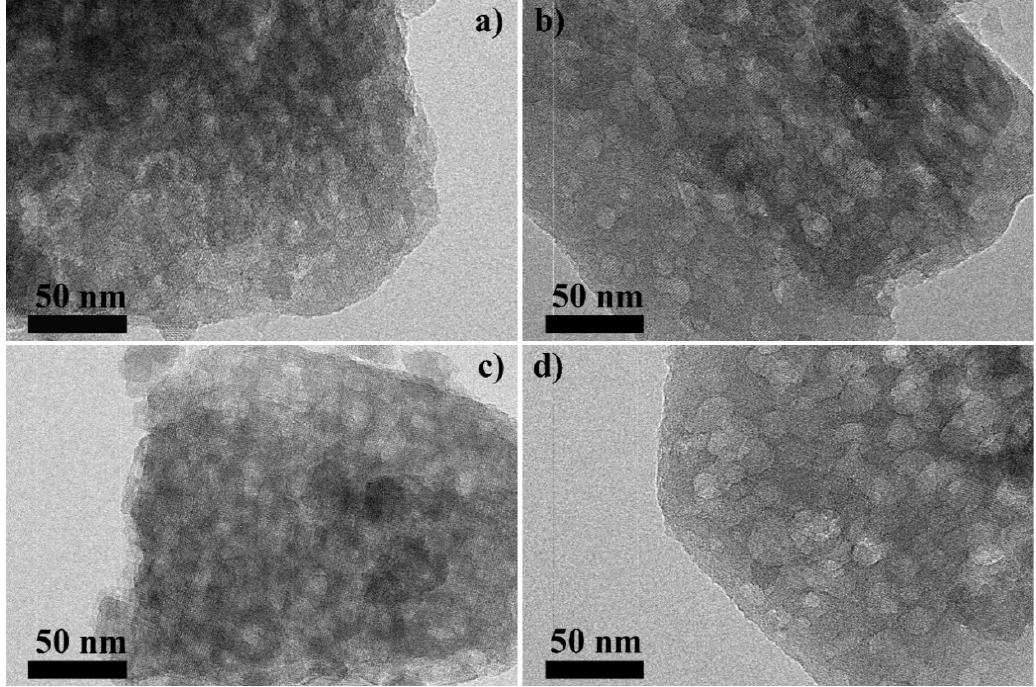
Figure 5. TEM micrographs of fluorination-alkaline treated samples. ( a ) AT(65,60)-FZ5a, ( b ) AT(65,60)- FZ5b, ( c ) AT(80,30)-FZ5a, ( d )